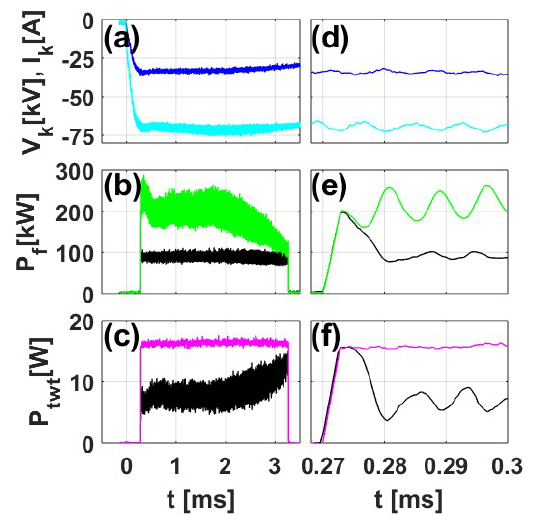
Fig 7. Voltage (light blue) and current (dark blue) supplied to klystron (a) exhibit ripple and droop over the high voltage pulse. Plotted in (b), the resulting change in klystron gain induces ripple and droop in RF power (green) which is stabilized with feedback control (black). Plotted in (c), the feedback controller modulates the output from the TWT (black) driving the klystron in inverse to the ripple and droop to stabilize RF power. TWT output power without feedback is shown in magenta. Zoomed values of (a,b,c) are plotted in (d,e,f). Voltage ripple (d, light blue) and power (e, green) are phase locked to with a constant phase offset. Settling time of feedback controller (e, black) is ~10µs after an initial power spike caused by integrator